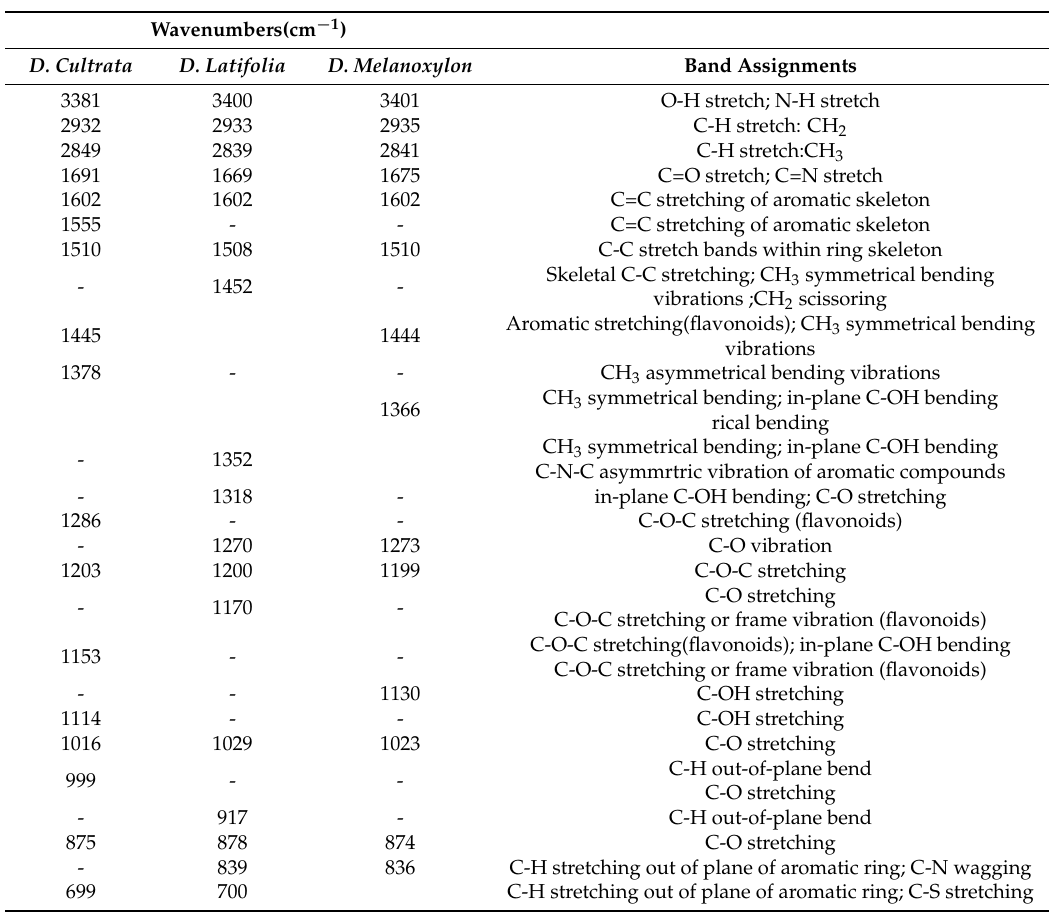
Figure 1. FTIR spectra: ( a ) D. cultrate , ( b ) D. latifolia , ( c ) D. melanoxylon. Table 2. FTIR band assignment.